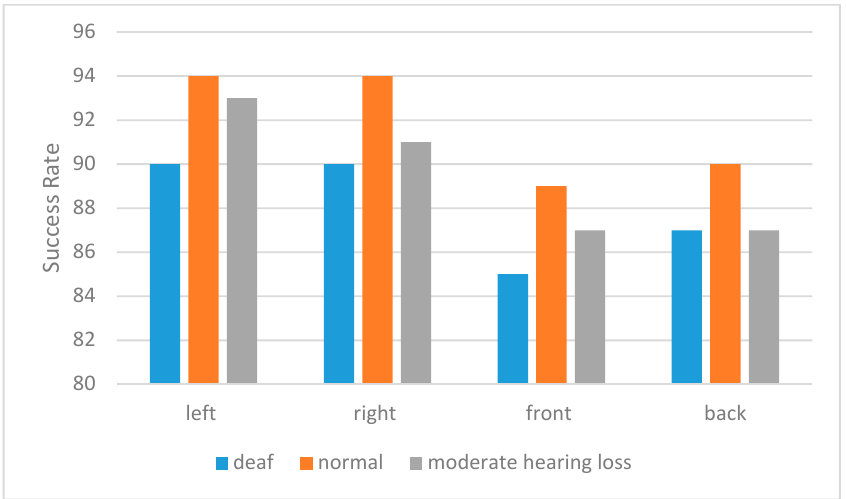
Figure 6. Success of deaf, moderate hearing loss and normal people to perceive the direction of voice.